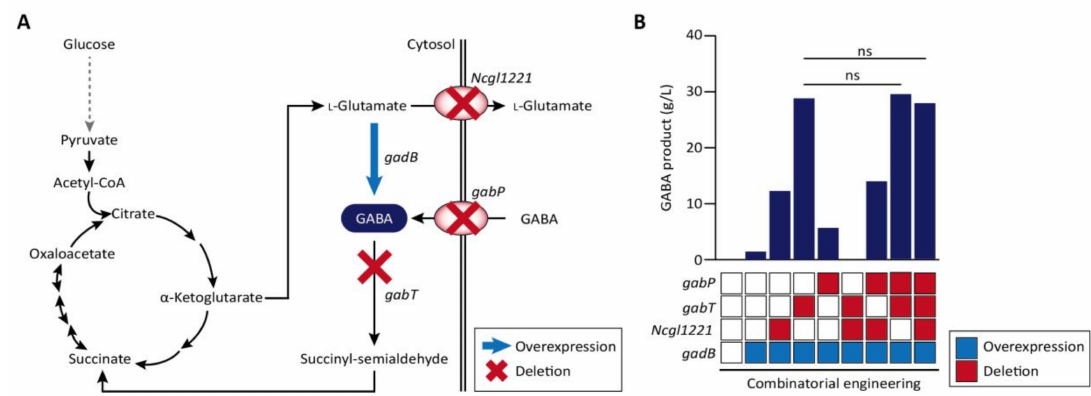
Figure 2. A metabolic engineering strategy for GABA production in wild-type C. glutamicum . ( A ) Metabolic pathway for GABA production in C. glutamicum , where genes Ncgl 1221, gabT and gabP encoding the L -glutamate transporter, GABA transaminase and GABA permease, respectively, are targeted for deletion, using CRISPR/Cas, and gadB is overexpressed. Dotted arrow indicates simplified schematic of glycolysis pathway. The enzymatic reactions are represented by two-way or single black arrows, according to the reversibility of the reactions. ( B ) Through combinatorial gene regulation of four genes, the key gene for GABA production was screened